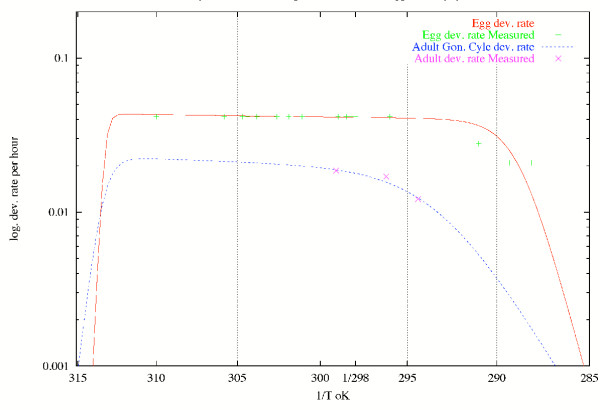
Egg and adult development rates.